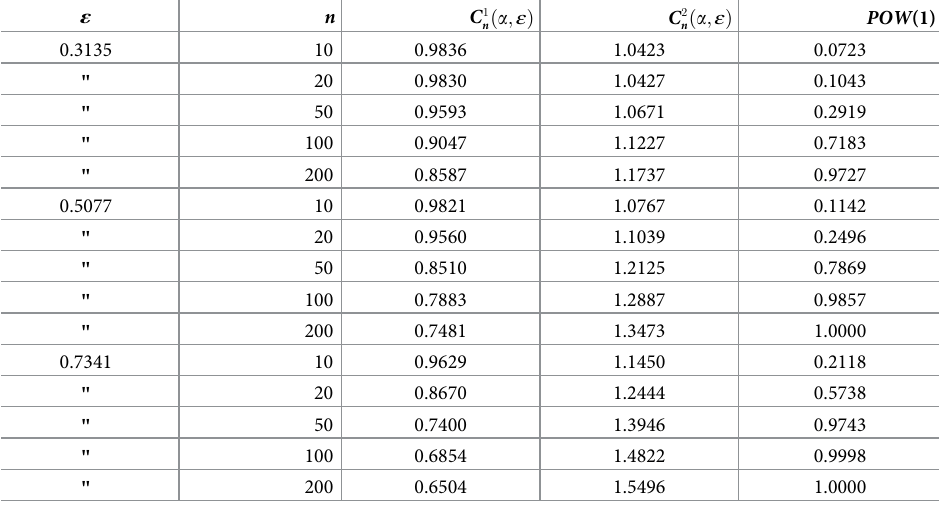
Table 2. Critical constants and power of the UMP test at level α = 0.05 to detect perfect fit of the model [ $ θ = 1] for various sample sizes and choices of the equivalence